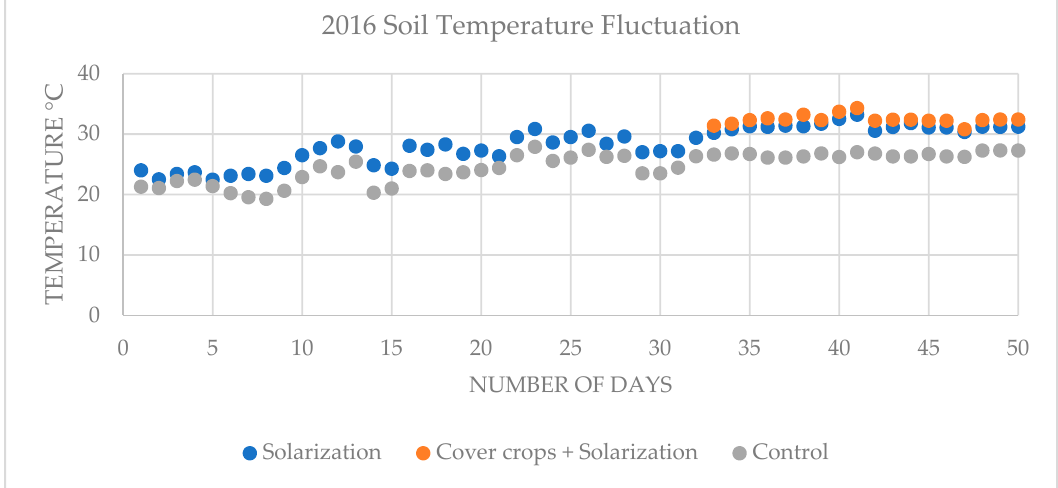
Figure 1. Soil temperature fluctuation in the top 15 cm of solarized beds, cover crops incorporated solarized beds and control non-treated, non-solarized beds in the 2016 on-farm experiment.